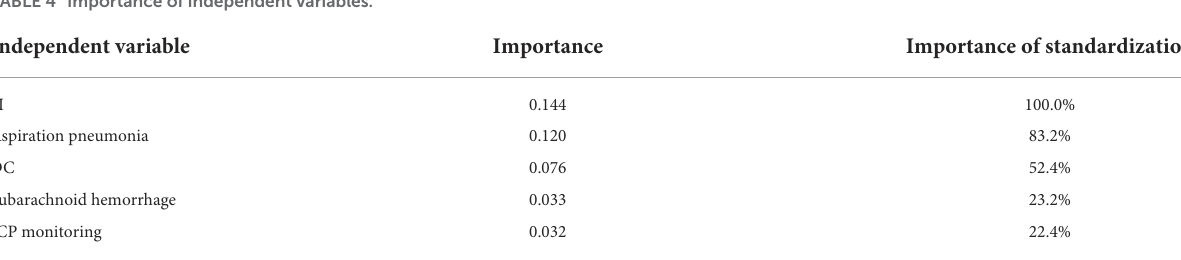
TABLE 4 Importance of independent